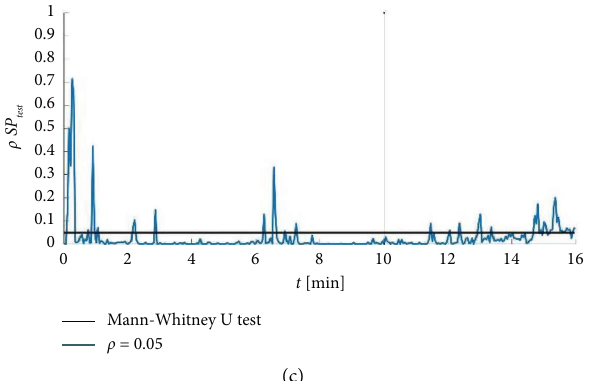
Figure 4: MATLAB trends of the SP test ® results depend on the latent trigger points presence and the SP test ® phase: (a) median value, (b) average value, and (c) Mann–Whitney U test results. Te LTrPs subjects presented abnormal autonomic activity that was confrmed by amplifed vasodilatation. Te MATLAB trends showed the development of the percentage size of amplifed vasodilatation spreading in the lower leg in time. Te signifcant diference between both groups stabilized around 2 ′ of the noxious stimulation, but in 4 ′ the size of the amplifed vasodilatation had a tendency to an intensive increase. Te control showed stable thermal fuctuations during the whole